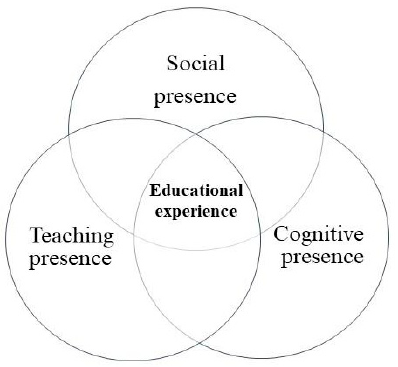
Figure 1. Community-of-inquiry framework [6] (p. 6).